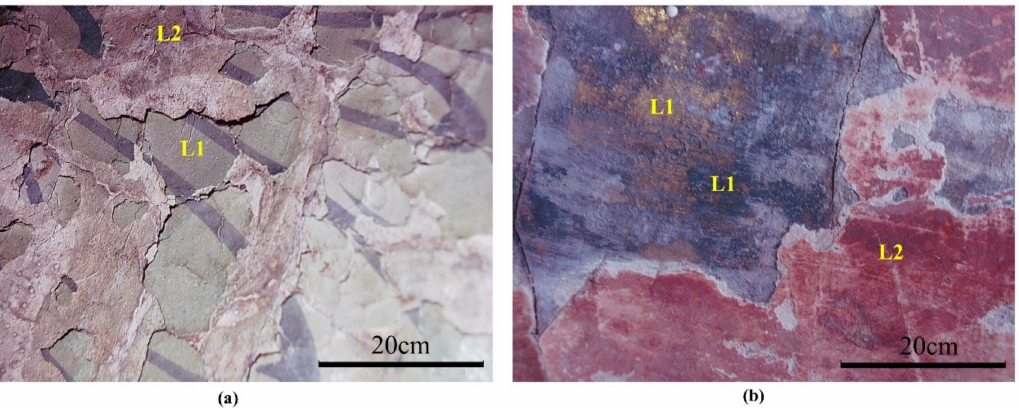
Figure 3. The in situ microphotographs of multiple paint layers: ( a ) at the sculpture of Ananda Buddha in the Xiasibei Hall (XSBD); ( b ) at the sculpture of Bodhisattva Manjusri in the Xiasinan Hall